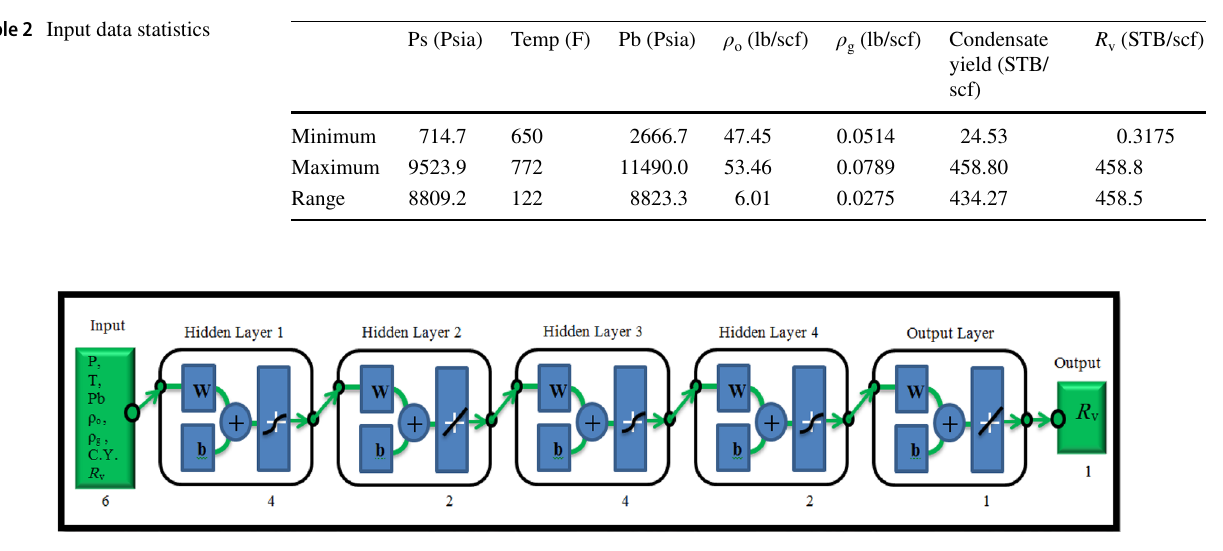
Fig. 1 Feedforward backpropagation, Type 1